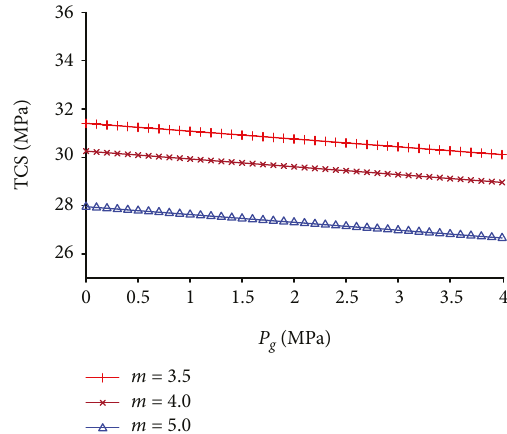
Figure 1: Theoretical curves of peak strength, gas pressure, and heterogeneity of heterogeneous soft coal rock mass ( σ internal friction angle = 8 °